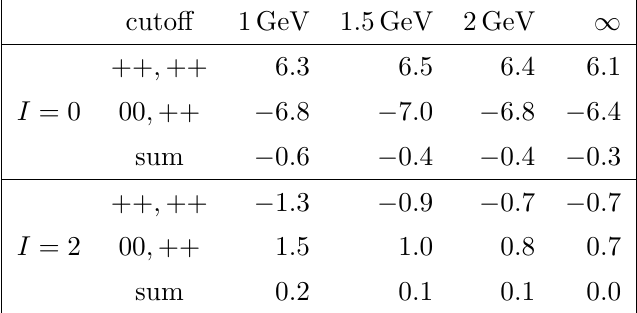
and h 0 as well as their sum once ++ ; ++ 00 ; ++ 2) (cid:22) master formula as explained in the main (cid:0)